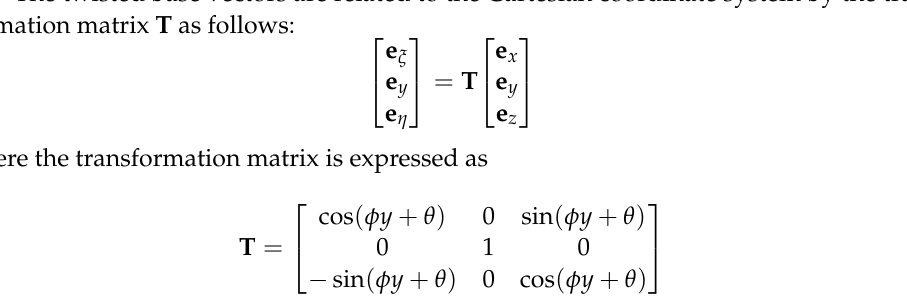
Figure 1. Geometrical description of a pre-twisted structure in the reference configuration with the Cartesian basis ( e x , e y , e z ), the twisted basis ( e ξ , e y , e η ), the covariant basis ( g 1 , g 2 , g 3 ), and the contravariant basis ( g 1 , g 2 , g 3 ).